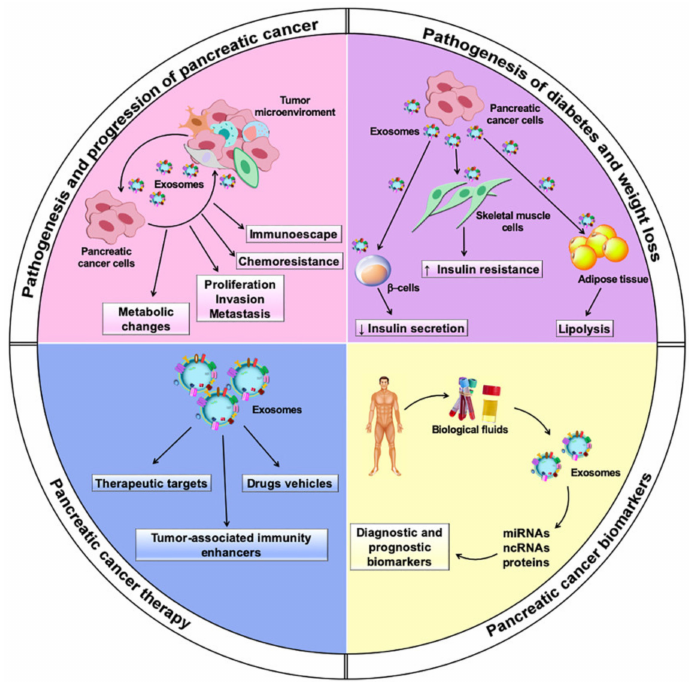
Figure 1. Multiple roles played by exosomes in pancreatic cancer. In the figure, the major topics discussed in the review are